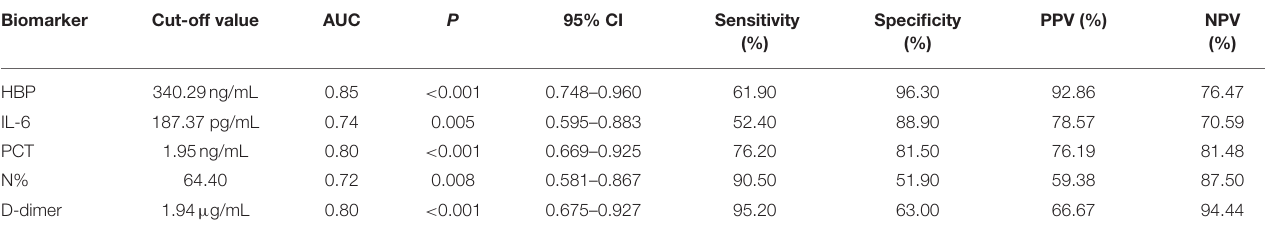
TABLE 5 | Performance characteristics of biomarkers for predicting severe sepsis.